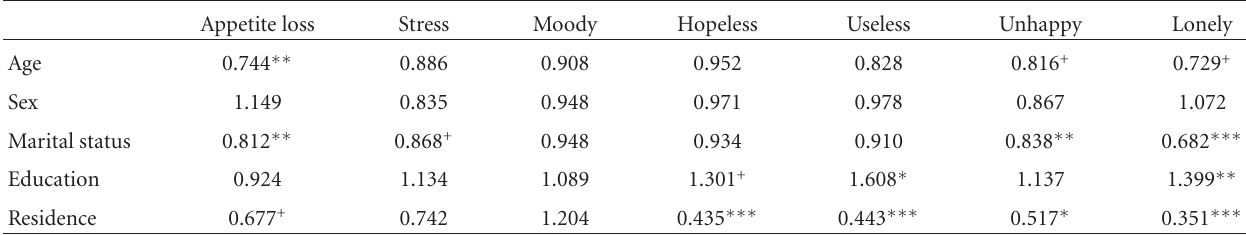
Table 3: Logistics regression results predicting indicators of social